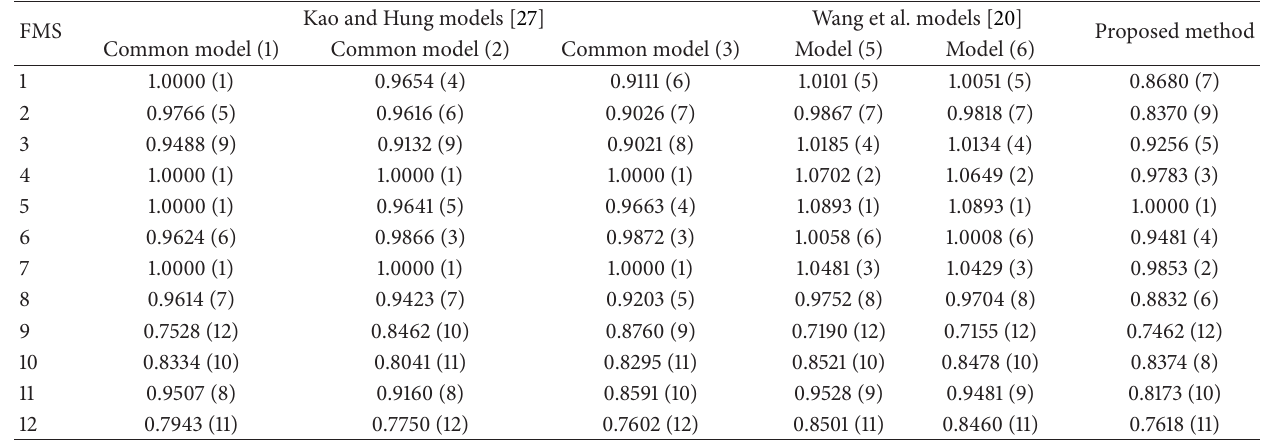
Table 2: The results of Example